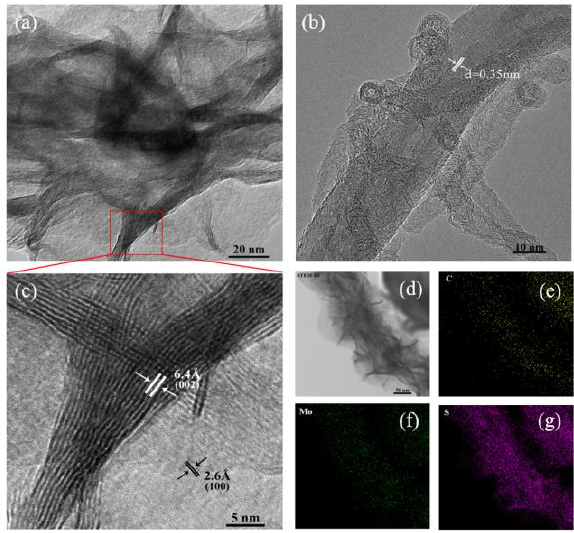
Figure 3. TEM image of ( a ) CGF; ( b ) s-MoS2@CGF; ( c ) TEM image of the s-MoS2@CGF; ( d ) STEM image of s-MoS2@CGF; elemental mapping images of ( e ) C, ( f ) Mo, and ( g ) S.